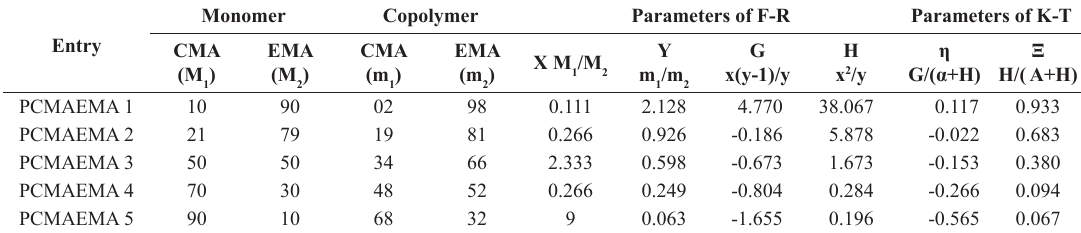
Table 1. F-R and K-T parameters for PCMAEMA copolymers.